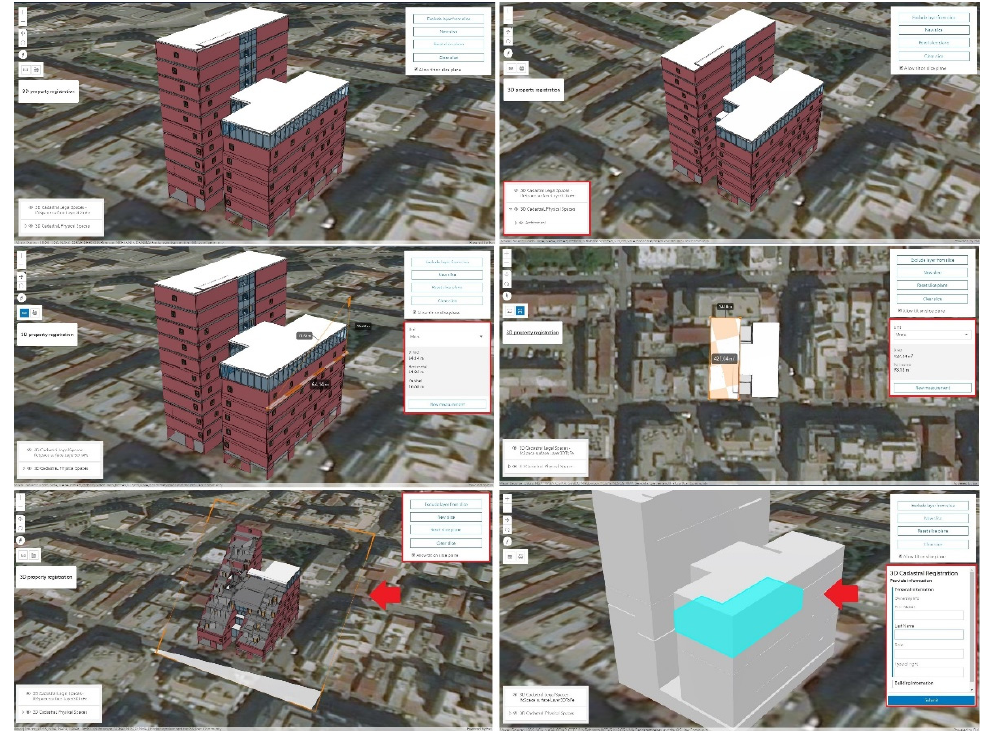
Figure 3. Top row ( left to right ): the application’s interface; and the layer management tool;. Middle row ( left to right ) the 3D length measurement tool; and the 3D area and perimeter measurement tool;. Bottom row ( left to right ): the building slicing tool; and the editor tool.